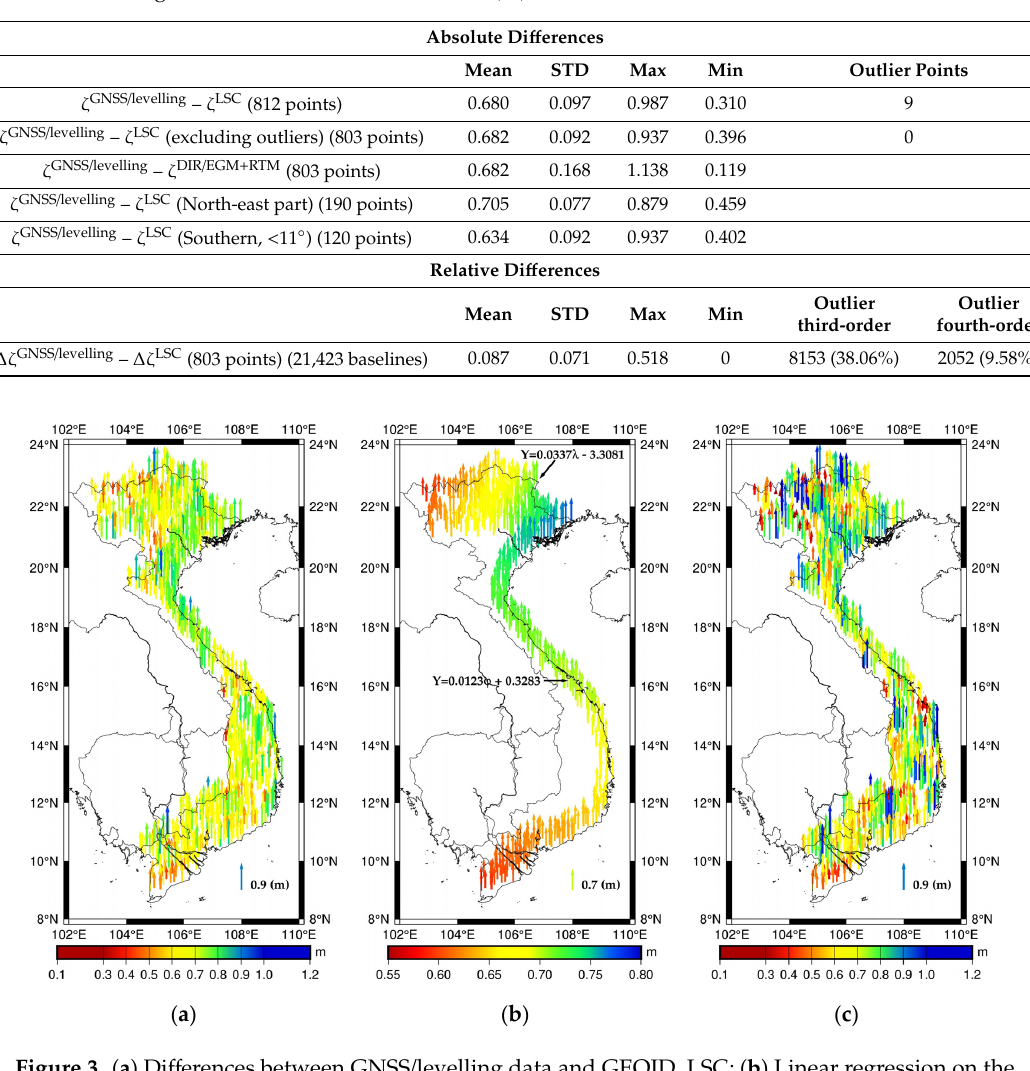
Table 2. Descriptive statistics of the absolute (residuals) and relative di ff erences between the 812 GNSS / levelling stations and GEOID_LSC. Unit: (m).